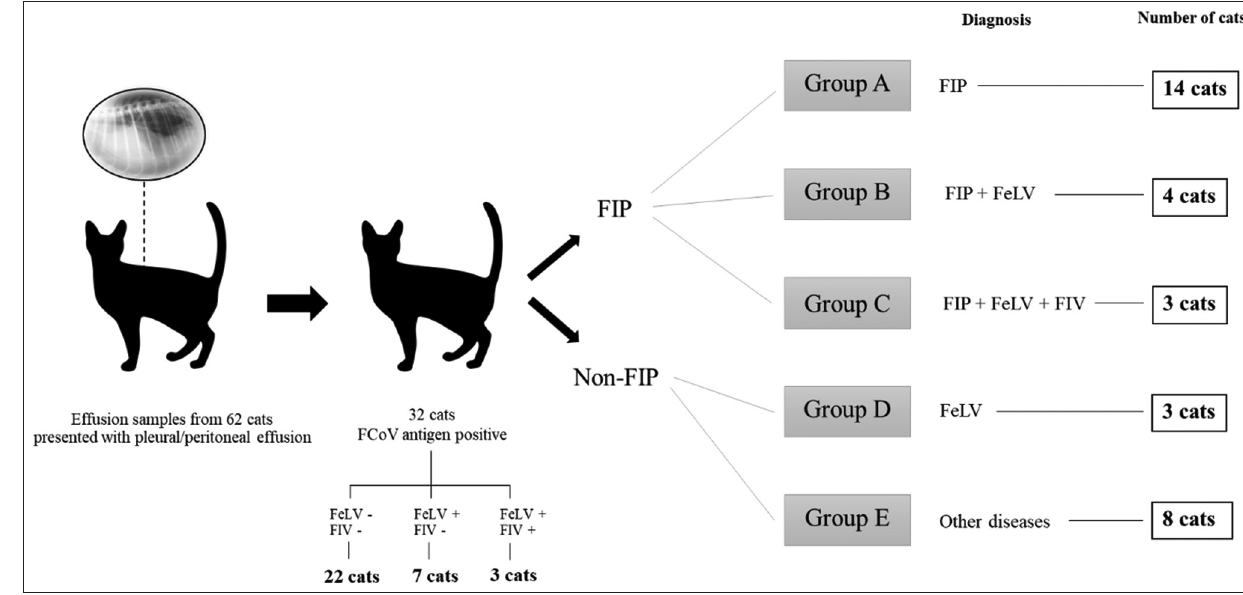
Figure-1: Sample groups in this